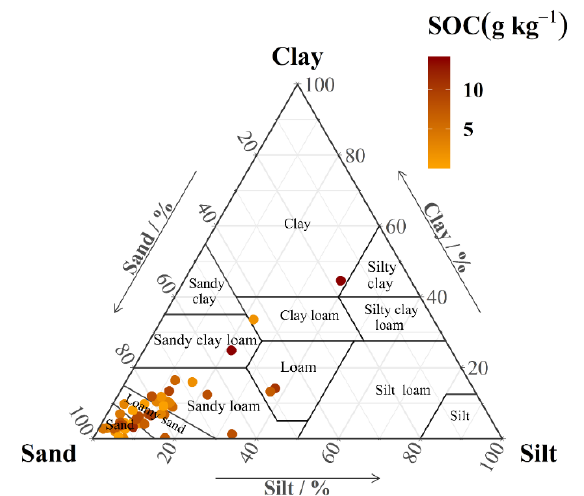
Figure 3. Overview on texture of analyzed referenced soil samples and soil organic carbon ( n = 45) of rice-based cropping system in Northeast Thailand (within the range of 0–40 cm depth) [45,50–52,54,57,61,63,65,66,68,69,81,82].